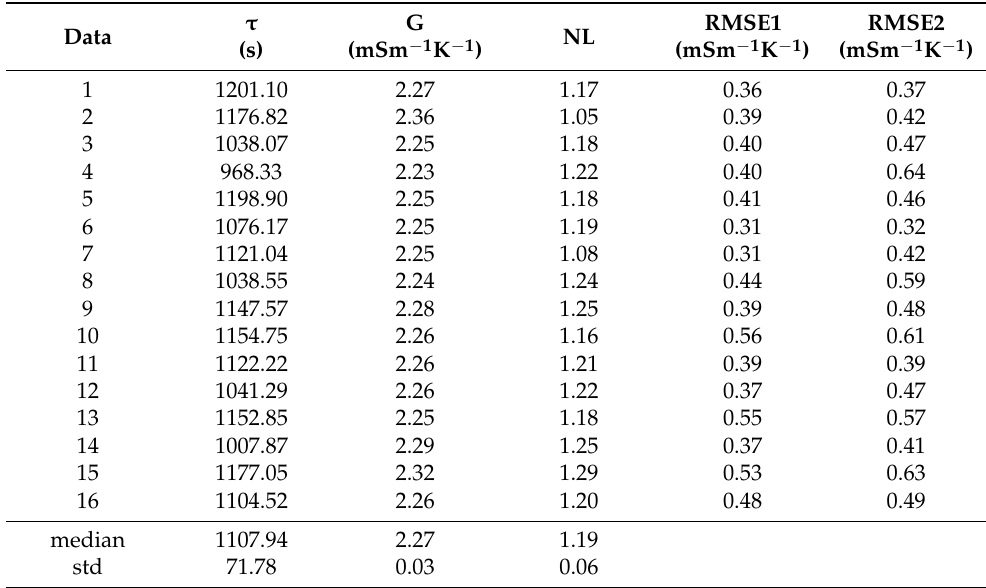
Table 1. Calibration parameters time constant ( τ ), Gain (G converted to ECa) and non-linear term (NL) and the resulting root mean square error (RMSE) for all 16 calibration measurements. The median and standard deviation (std) of the fitted parameters are also provided.